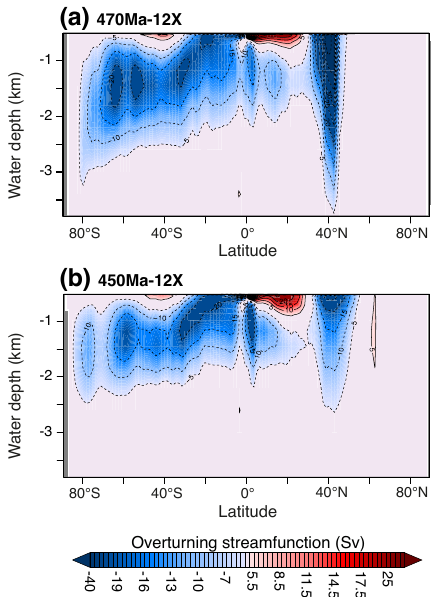
Figure 10. Comparison of the global meridional overturning circu- lation simulated at 12PAL with the fully coupled version of FOAM for the two continental configurations used in this study. Red shad- ing and solid contours indicate a clockwise circulation, blue shading and dashed contours indicate a counter-clockwise